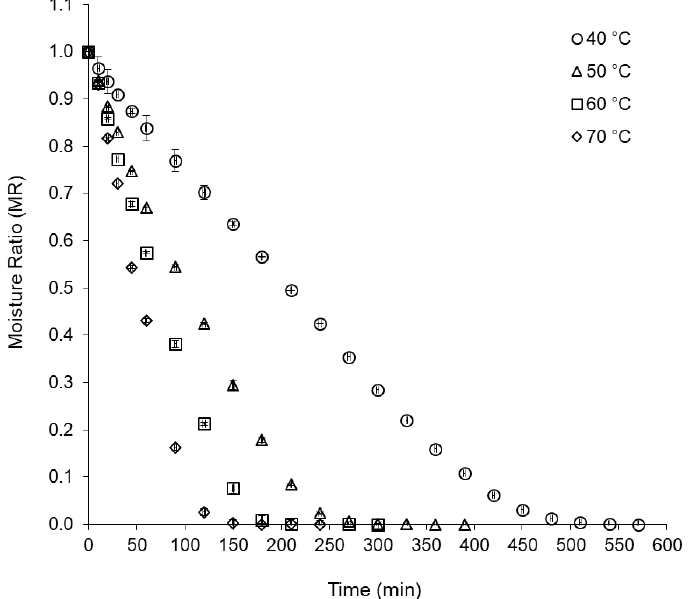
Figure 1. Drying curves of purple basil leaves at temperatures of 40 °C, 50 °C, 60 °C, and 70 °C. Similar drying behaviors were observed for rosemary leaves ( Rosmarinus officinalis L.) dried by hybrid convective and microwave drying processes, under a vacuum [34]; for L.) dried by microwave [36]. Mbegbu, Nwajunka, and Amaefule [37] reported that diffu-